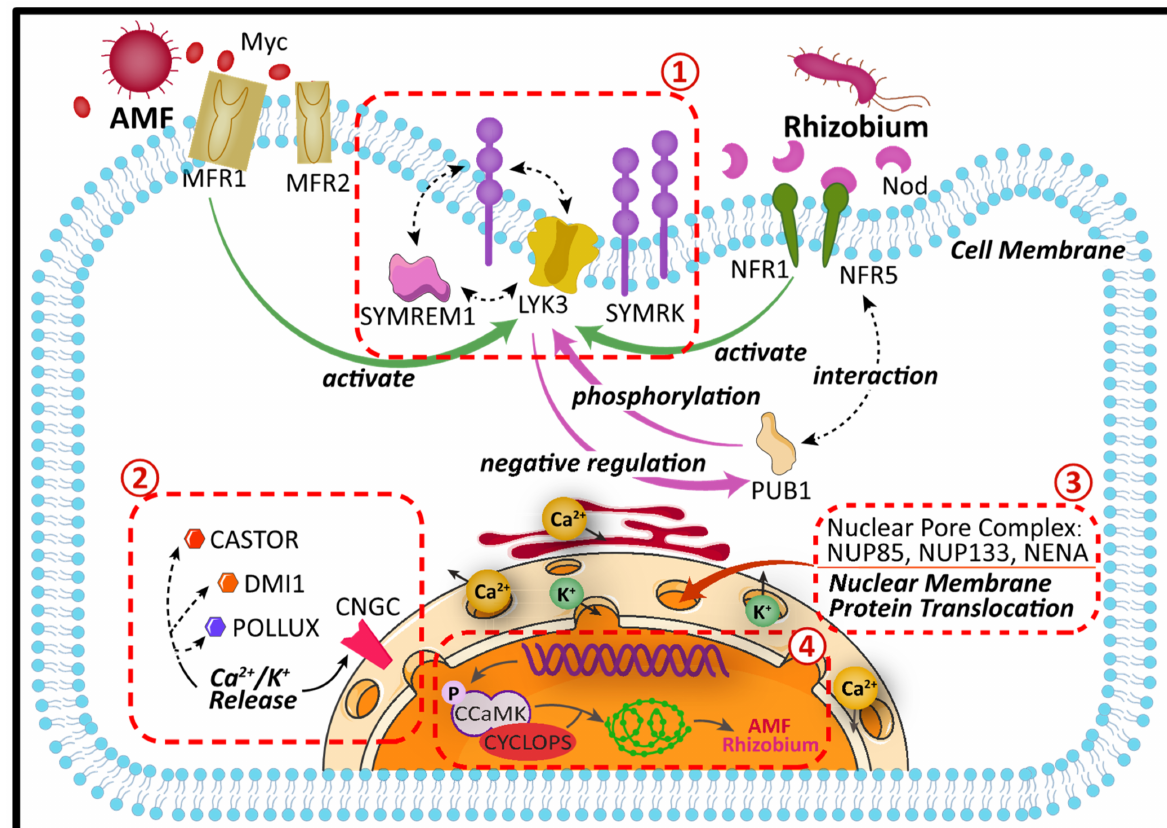
Figure 2. Major components in plant (vacuole omitted) symbiosis with AMF and Rhizobium involved in symbiotic signaling. 1 (cid:13) , 2 (cid:13) , and 3 (cid:13) represent the three possible signal processes in this pathway (extramembrane signal, extranuclear signal, and intranuclear signal,